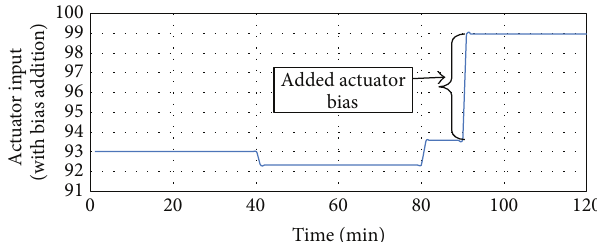
Figure 6: Training method for the heat release estimator.